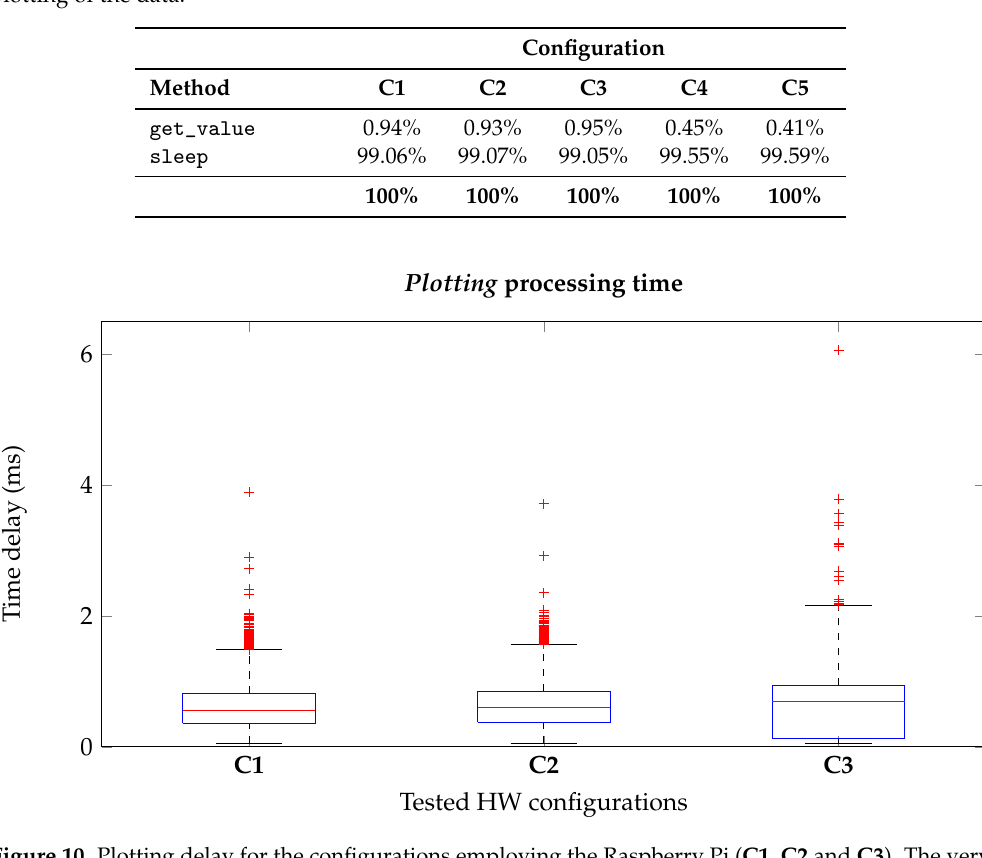
Figure 10. Plotting delay for the configurations employing the Raspberry Pi ( C1 , C2 and C3 ). The very low plotting-time proves the real-time graphical representation by our